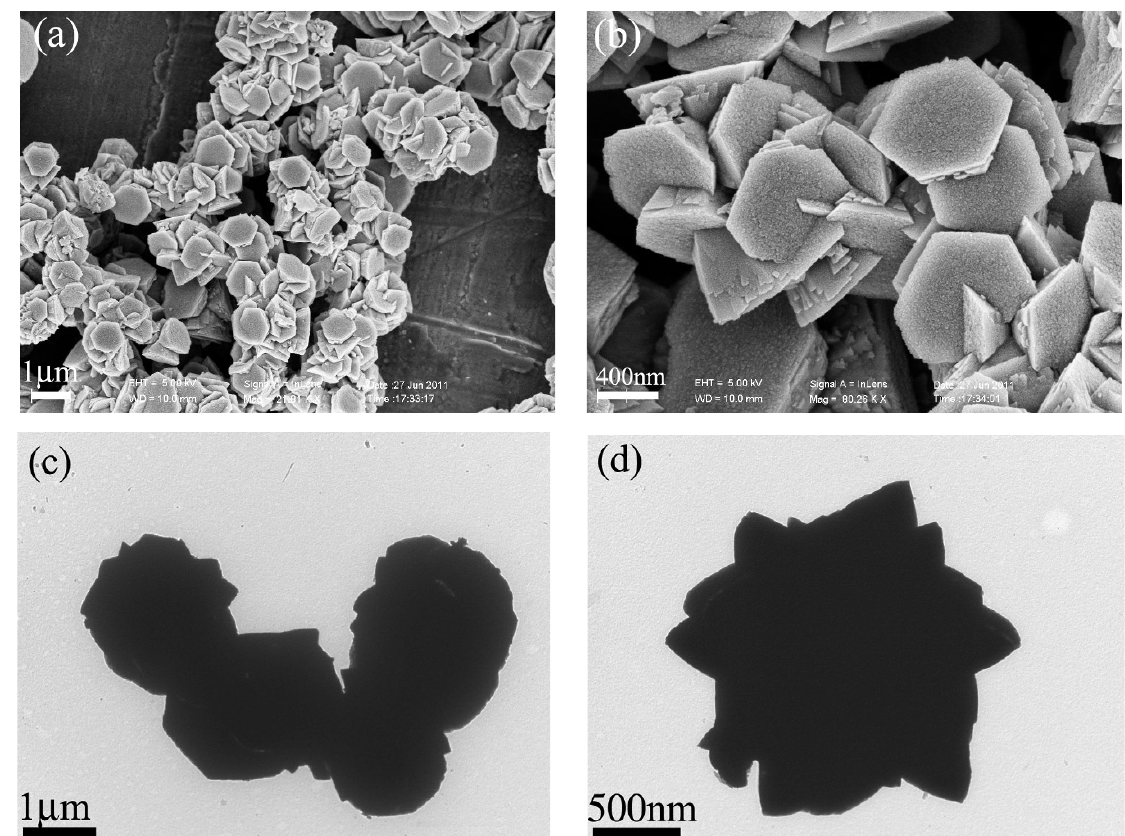
Figure 2. (a) A low magnification FESEM image of the polyhedral CdS architectures; (b) a high magnification FESEM image of the polyhedral CdS architectures; (c) a low magnification TEM image of polyhedral CdS architectures; (b) a high magnification TEM image of polyhedral CdS